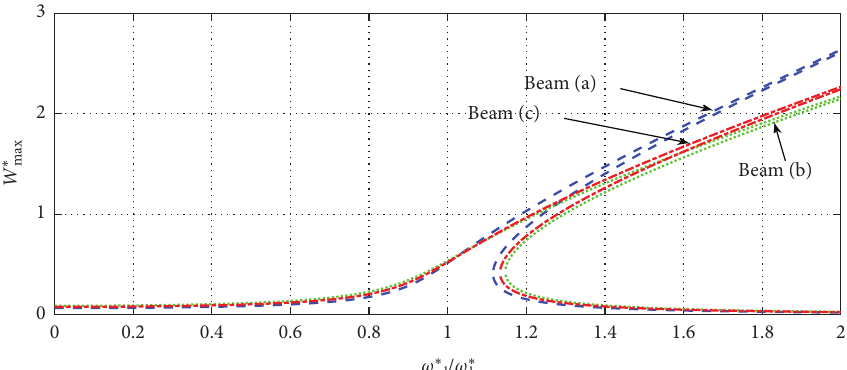
Figure 12: Nonlinear frequency response functions, based on a multimode approach, for the three different beams, which are excited by a uniformly distributed harmonic force.